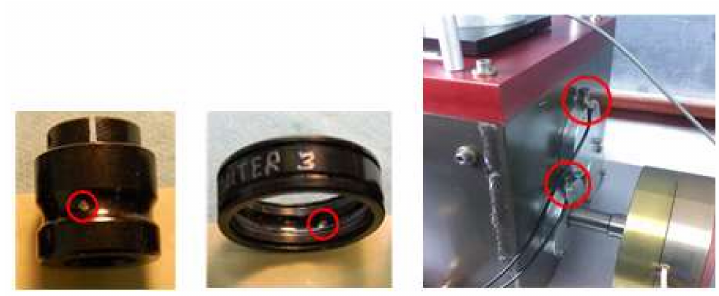
Figure 15. The IRF and ORF rolling bearings, and two sensors of one side.